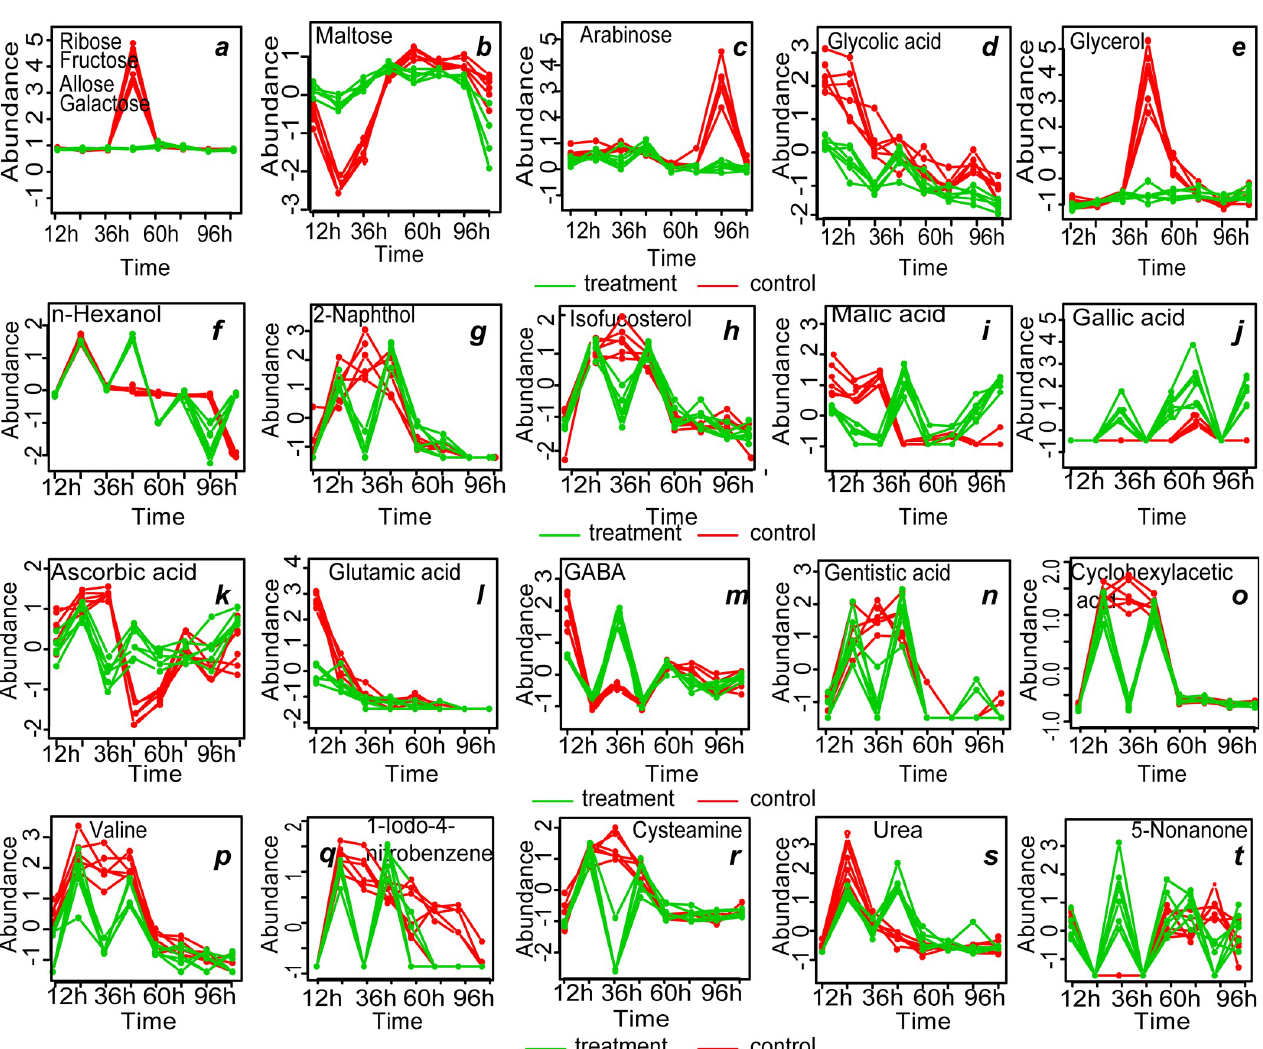
Fig 7. MEBA of U . prolifera metabolites that met the following criteria: potential biomarkers according OPLS-DA, well-modeled by SPE and with Hotelling’s T2 value > 100.